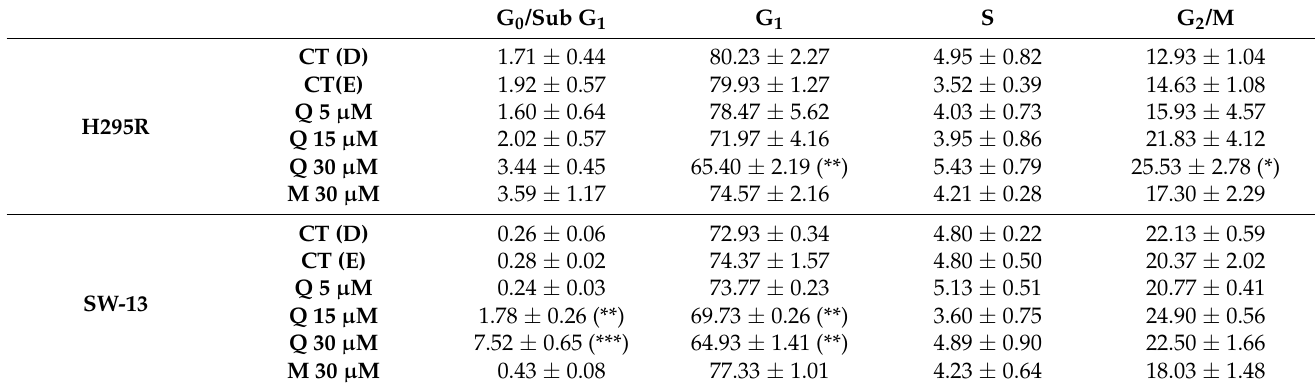
Table 2. Percentage of 7-AAD staining on H295R and SW-13 cells, according to the cell cycle